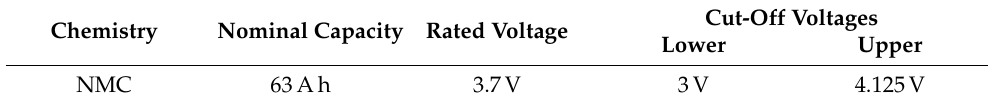
Table 1. Characteristics of Li-ion cells used.